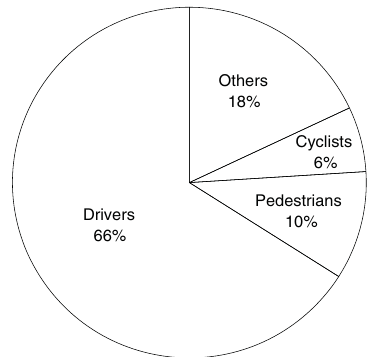
Fig. 5. The percent distribution of traffic accident guilty parties in Lithuania in 2012 (the total number of the registered accidents was 3173)